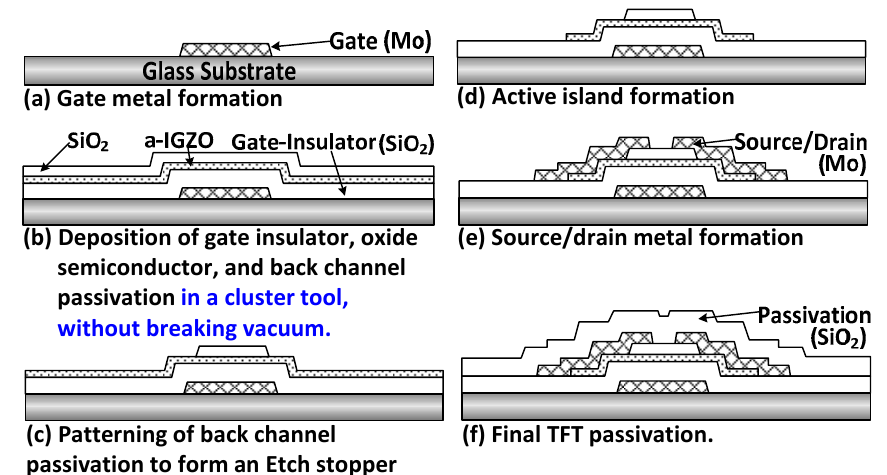
Figure 1. Optimized mixed oxide thin-film transistor passivation. In ( b ), the consecutive deposition of a SiO 2 layer by plasma-enhanced chemical vapor deposition (PECVD) as the gate-insulator, deposition of an amorphous indium-gallium zinc-oxide (a-IGZO) layer by sputtering, and deposition of a SiO 2 back passivation layer by PECVD in a cluster deposition tool, without breaking vacuum, ensures the in situ passivation of the a-IGZO, immediately after deposition. This, in turn, ensures an uncontaminated and very stable a-IGZO layer, necessary for the detection of intrinsic characteristics, rather than fabrication process-related variations.